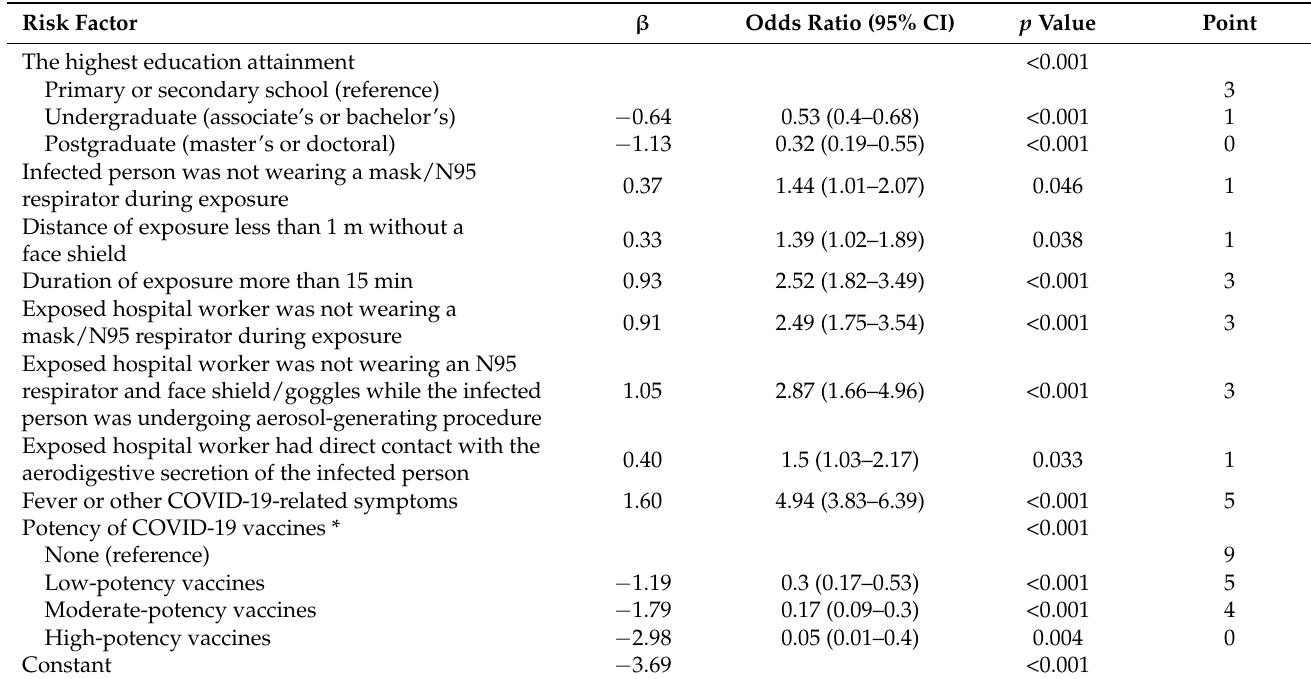
Table 3. Independent risk factors associated with subsequent SARS-CoV-2 infection after occupational exposure among hospital workers, coefficients from the final logistic model, and weight (point) for the risk score.